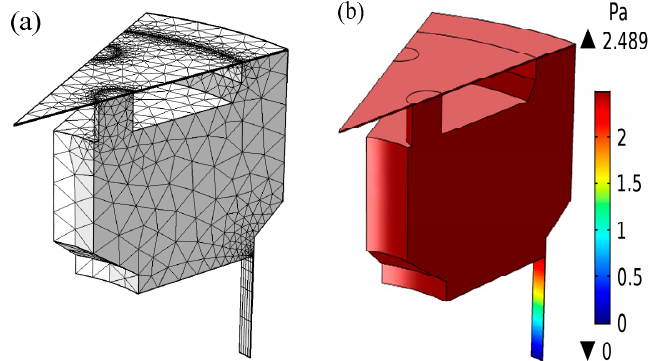
Figure 8. ( a ) The FEA model of the microphone. ( b ) Sound pressure distribution for the heat conduction and leaking condition at 0.1 Hz, in which the sound pressure decreases to almost 0.